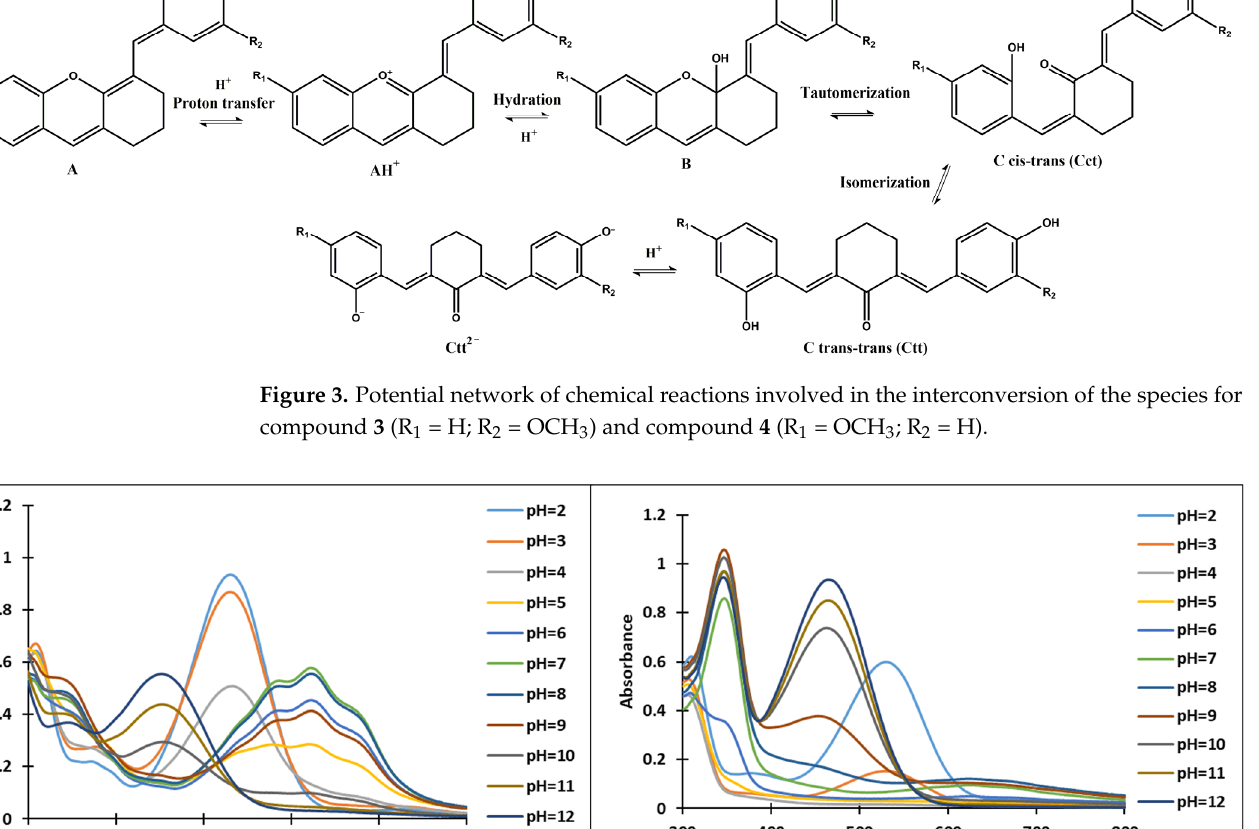
Figure 3. Potential network of chemical reactions involved in the interconversion of the species for compound 3 (R 1 = H; R 2 = OCH 3 ) and compound 4 (R 1 = OCH 3 ; R 2 = H).